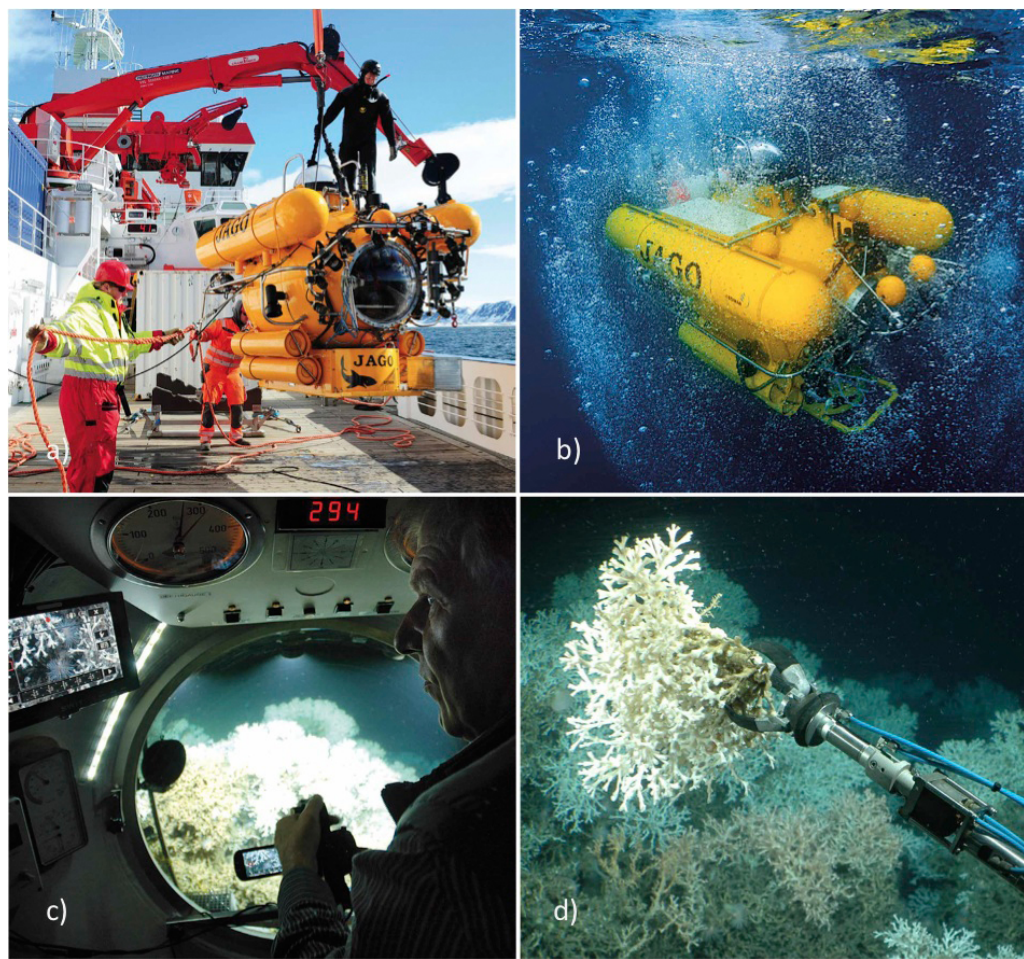
Figure 1: Manned Submersible “JAGO”, a) recovered by the crew of the German research vessel “MARIA SYBILLE MERIAN” after a dive off Spitsbergen / Norway, b) approaching the surface after a dive off Namibia, c) pilot Jürgen Schauer adjusts HD video camera for filming cold water corals in a deep reef off Norway, d) non-intrusive sampling of cold water corals with JAGO’s manipulator arm. JAGO is an extremely compact and light-weight manned submersible for its depth class. It is 3 m long, 2 m wide and 2.5 m high. The weight in air is 3